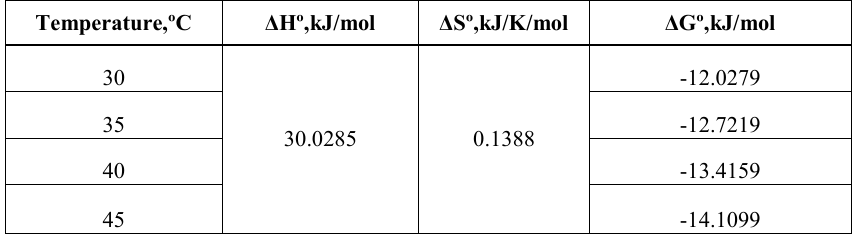
Table 4 : Thermo dynamical parameters for the adsorption of AV 49 onto